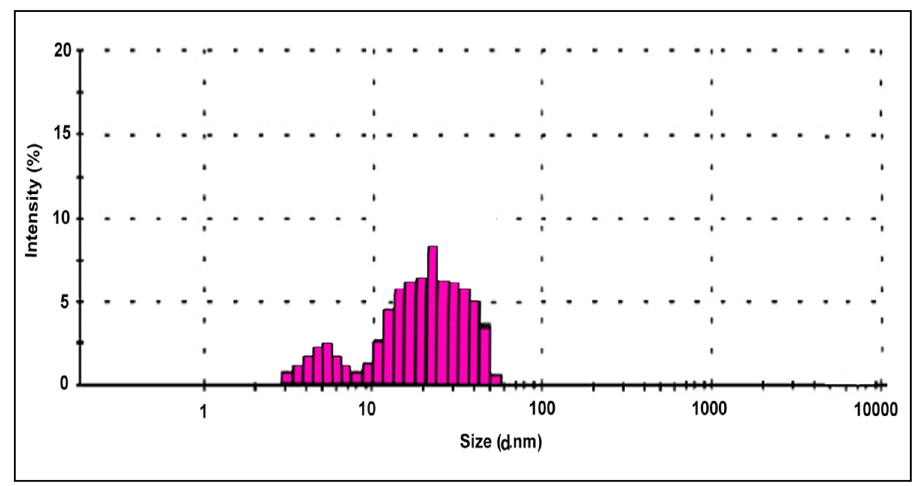
Figure 8: DLS spectrum of Z. mays silk - fabricated AgNPs.